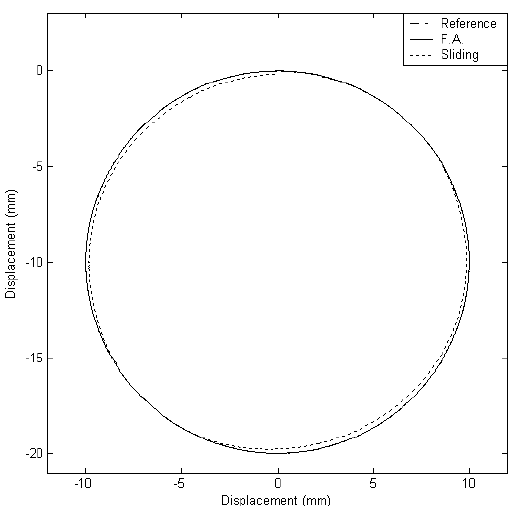
Figure 5. X-Y table displacement (case